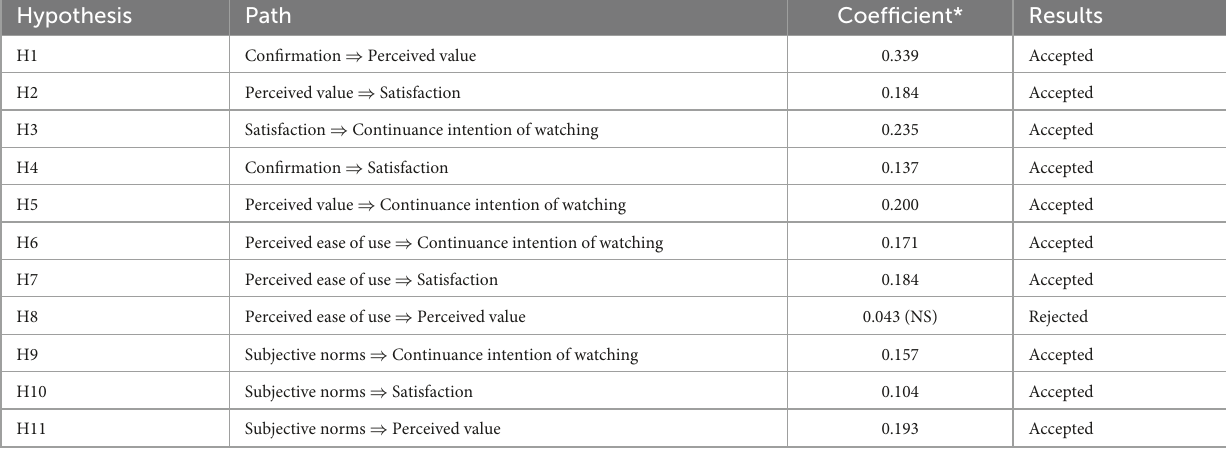
TABLE 6 Summary of